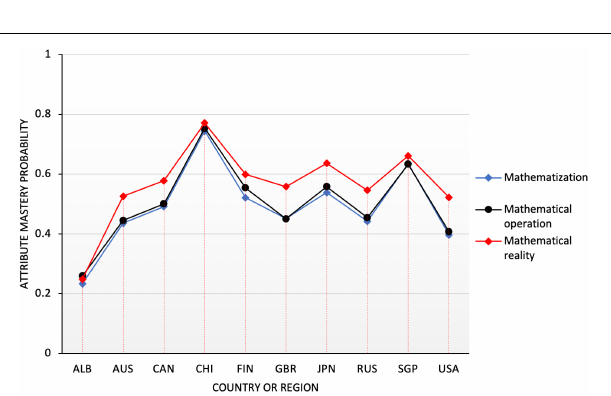
FIGURE 2 | Probability distribution map of process attributes in 10